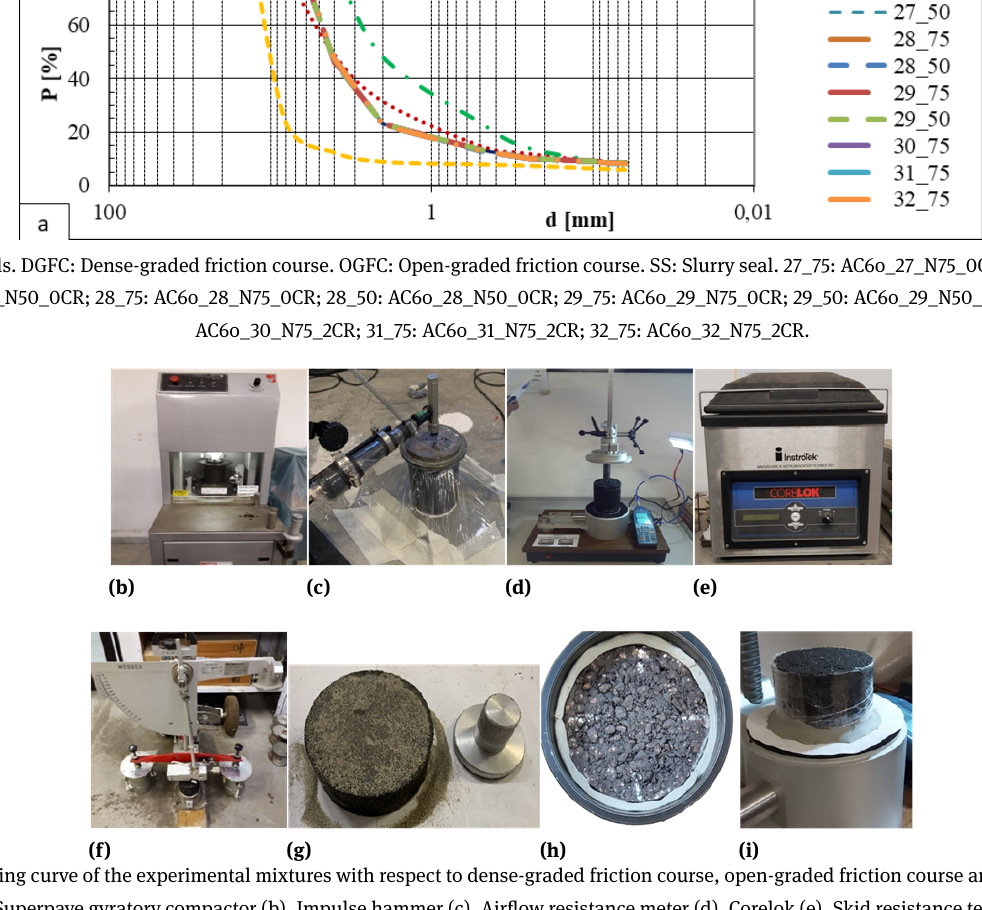
the porosity can be calculated as indicated by the